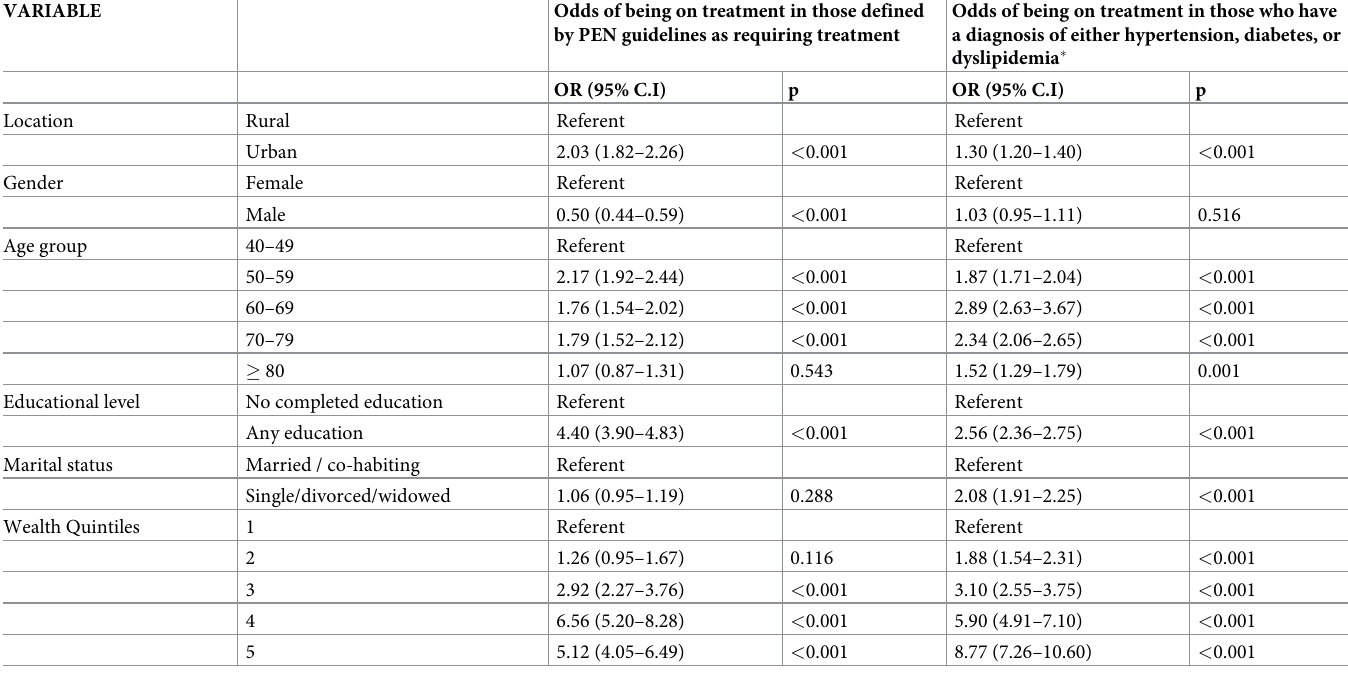
Table 4. Multivariable associations between weighted demographic characteristics and being on any treatment.